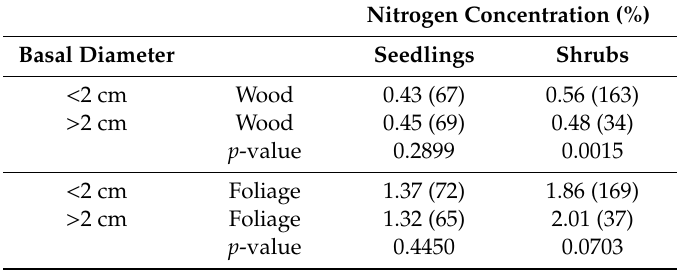
Table 5. Thirty-year post-treatment measures (means) of nitrogen (N) concentration (%) in the wood (branches) and foliage of tree seedlings and shrubs (excluding N-fixing species) observed in the Miller Creek Demonstration Forest, Montana, USA. Sample numbers shown in parentheses. Values for individual species shown in Table S5.